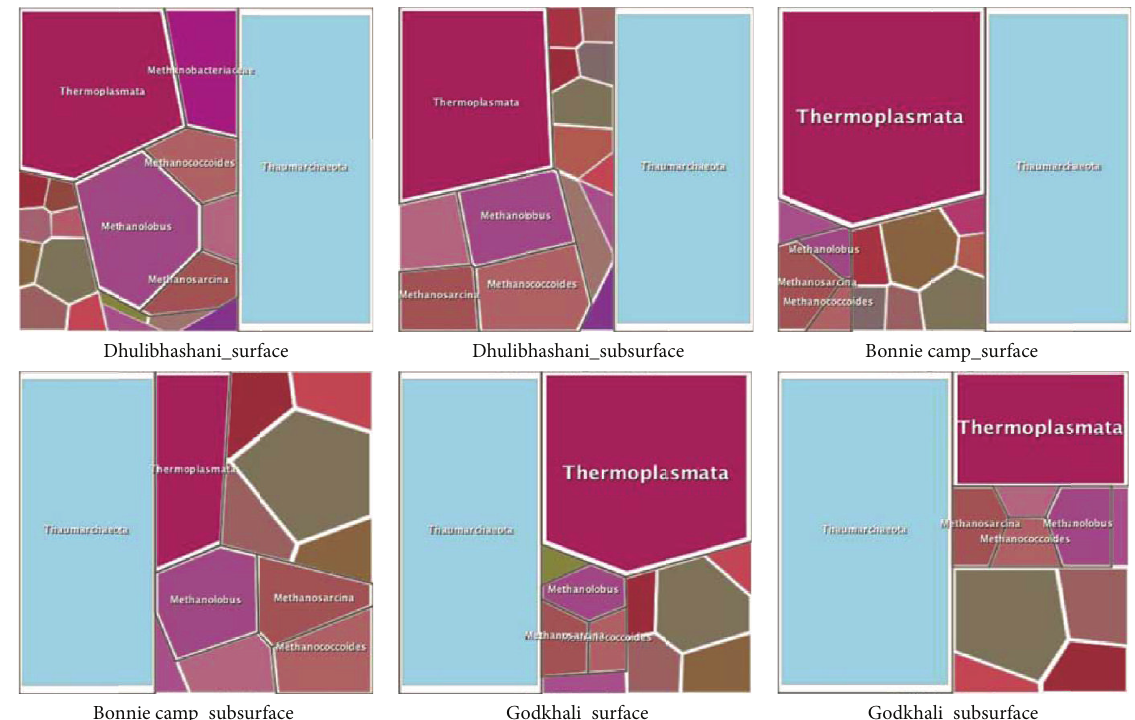
Figure5:Voronoidiagramdepictingcomparativetaxonomicprofilecompositionpatternforeachsampleasapartitionofaplanehighlighting 6 major